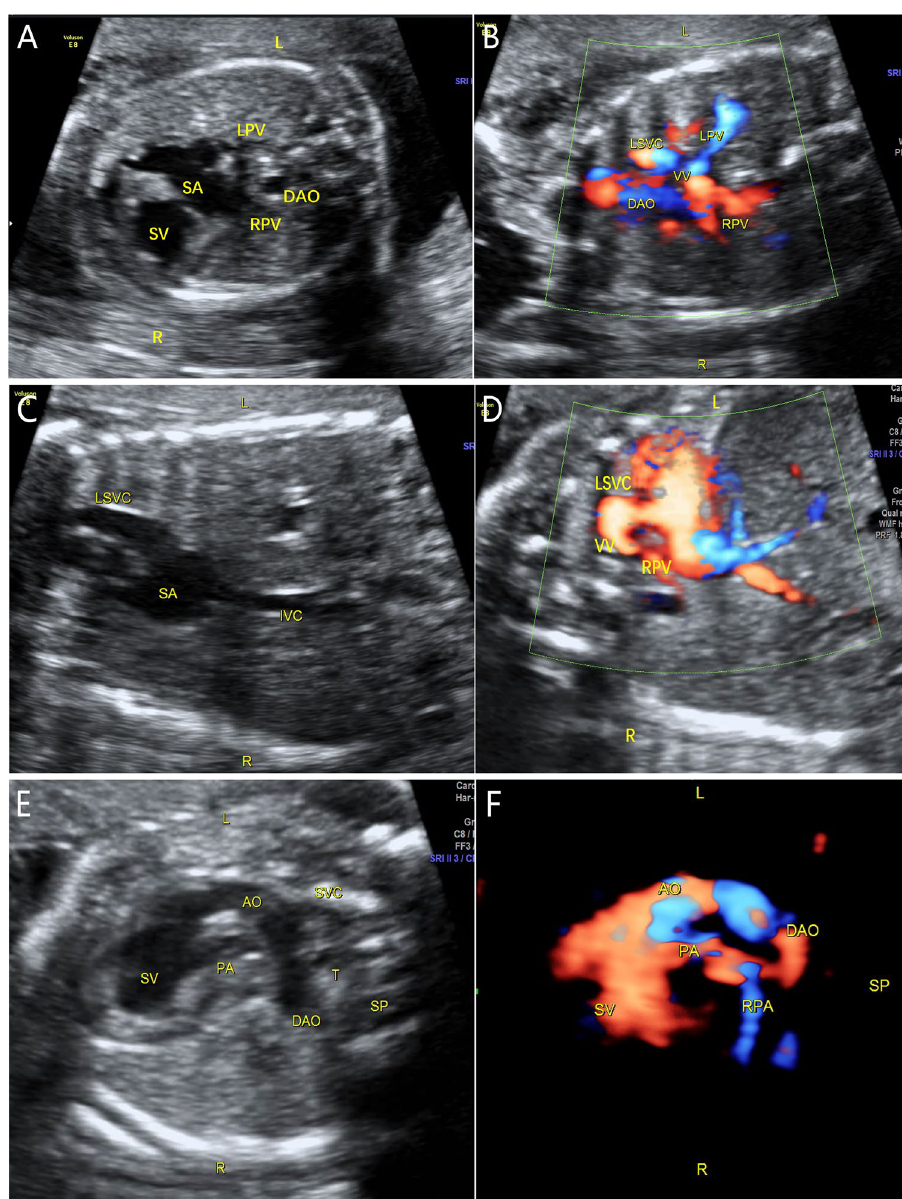
Figure 1. Prenatal ultrasound diagnosis of fetal supracardiac TAPVC with complex malformations. ( A ) The common PV trunk was visible in the cross section of the atrium, and posterior left atrium index was increased. ( B ) Vertical venous return to the left superior vena cava. ( C , D ) Superior and inferior vena cava return to a single atrium. ( E , F ) Two- and 3-dimensional flow imaging revealed both the aorta and pulmonary artery originating from a single ventricle with pulmonary stenosis. DAO descending aorta, L left, LPA left pulmonary artery, R right, RPA right pulmonary artery, SA single atrium, SV single